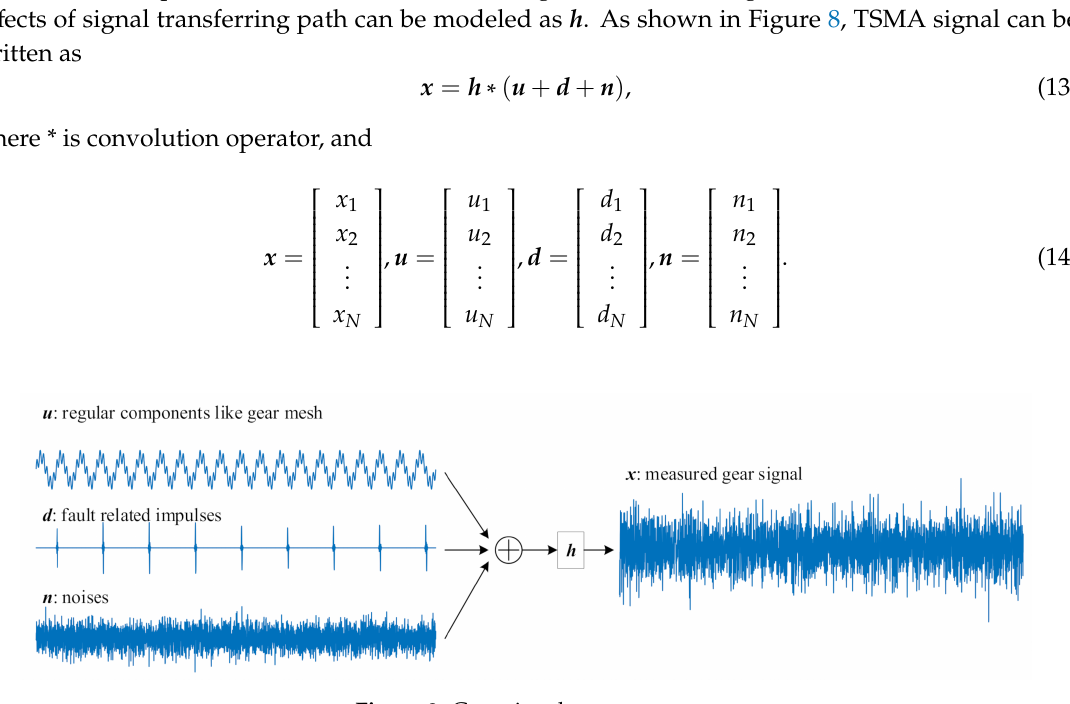
Figure 8. Gear signal